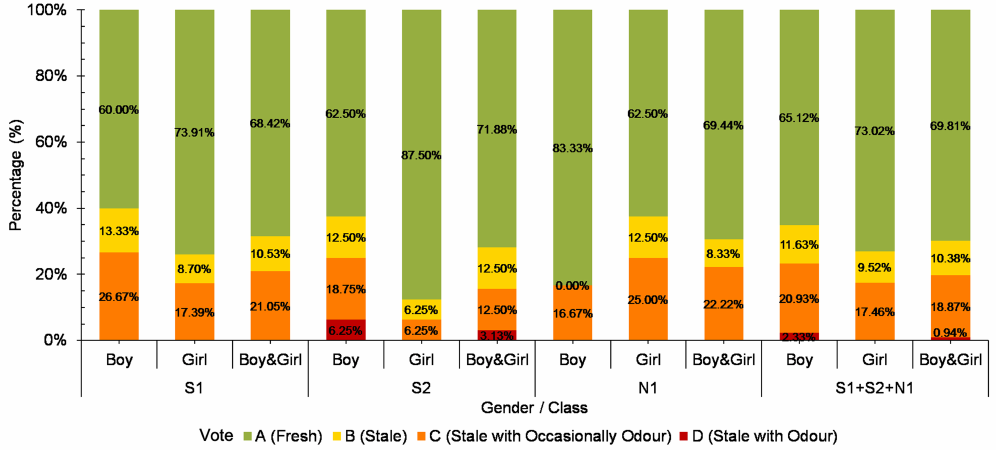
Figure 7. The air freshness votes in the three study classrooms.